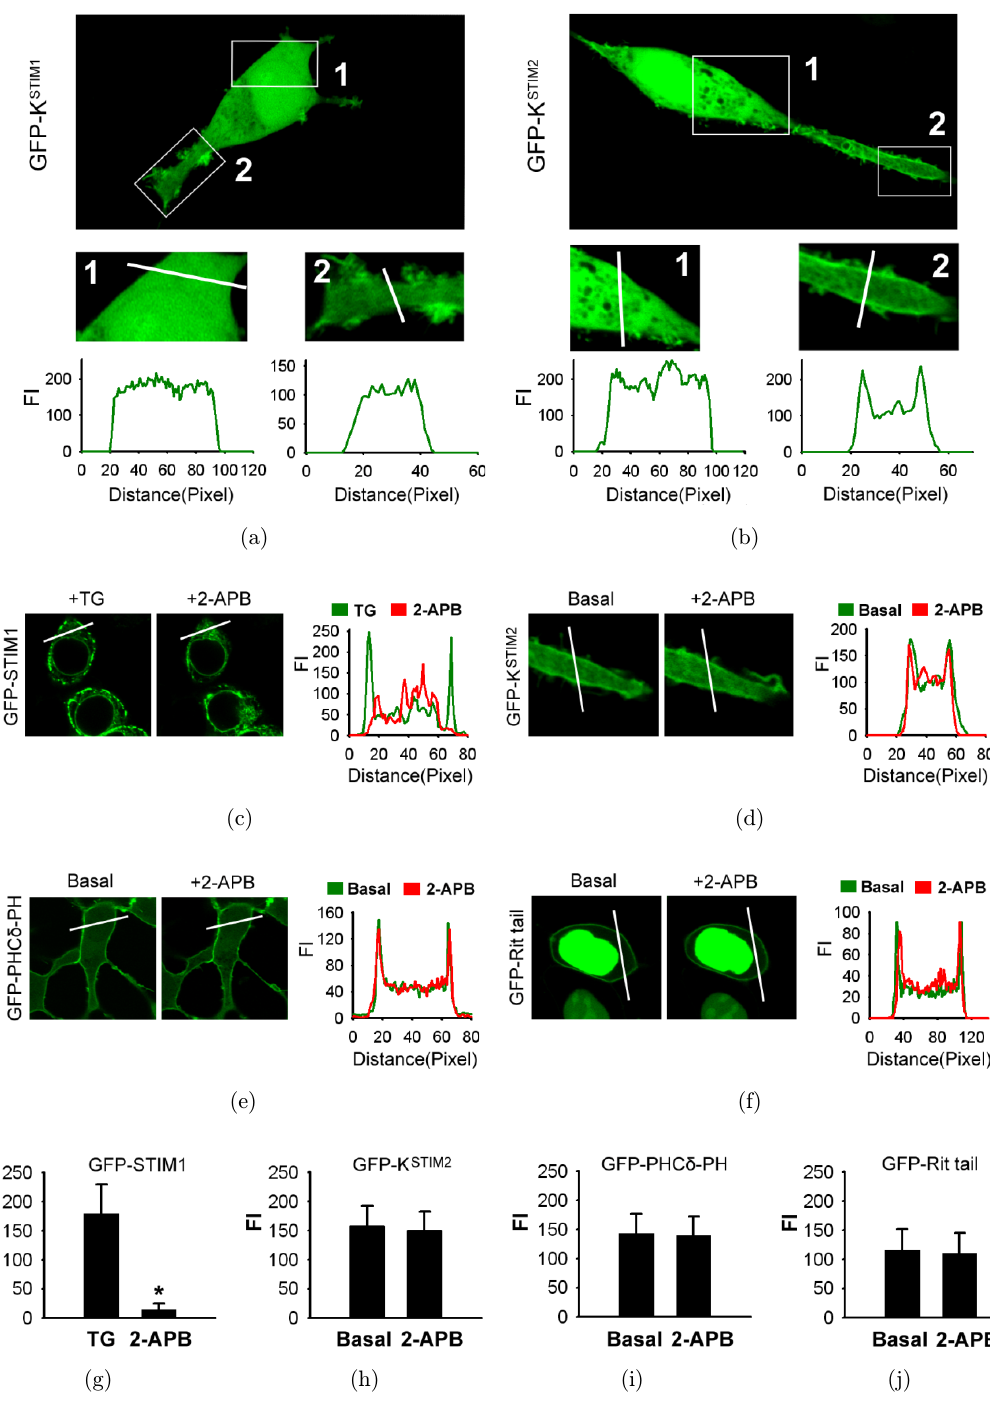
Fig. 3. 2-APB has no e®ect on the binding between polybasic domain and PM phosphoinositides. (a) Representative confocal images from HEK293 cells expressing GFP-K STIM1 . Line scans were taken from marked areas (solid squares 1 and 2) and show pro¯les of °uorescence intensity against line distance. (b) Representative confocal images from HEK293 cells expressing GFP-K STIM2 . Line scans were taken from marked areas (1 and 2). Line scans from areas 2 show that GFP-K STIM2 is partially localized to the PM. (c) Confocal images of GFP-STIM1-expressing cells in the presence of TG (left panel) and 5 min following addition of 50 (cid:1) M 2-APB in the continued presence of TG (center panel). Right panel shows merged pro¯les of °uorescence intensity against line distance. (d – f) Representative confocal images from HEK293 cells expressing GFP-K STIM2 , GFP-PLC (cid:2) -PH, and GFP- Rit tail, respectively, in the absence (left panel) and presence (center panel) of 50 (cid:1) M 2-APB. (g – j) Bar graphs show the change of PM °uorescence intensities from 2-APB-treated experiments shown in (c) – (f), respectively.